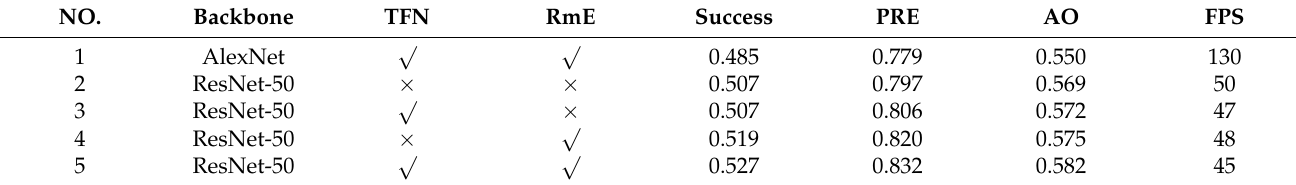
Table 3. A comparison of evaluation results of with or without TFN block and RmE block and different backbone on multiple datasets. Success represent accuracy on LaSOT; PRE represent Precision on UAV123 benchmark. AO represents accuracy on GOT-10K; FPS selects the operation results on GOT-10K data